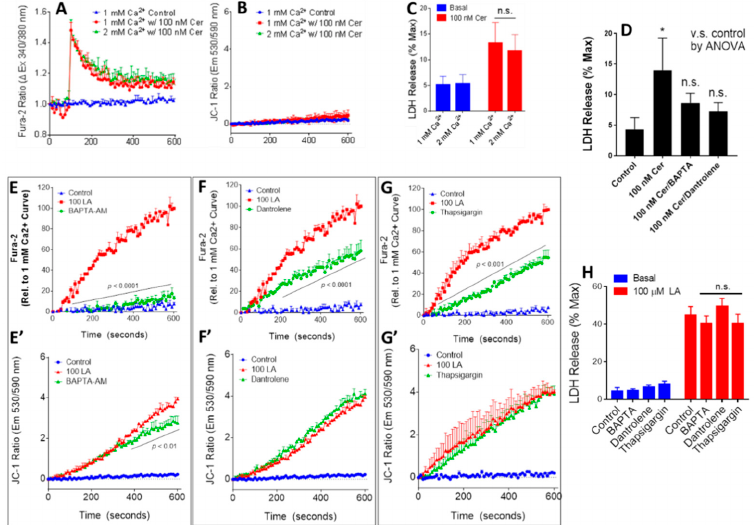
Figure 3. Effect of altering calcium on caerulein-induced ( A – D ), and changing Cai on LA-induced ( E – H ) acinar cell injury. ( A ) Extracellular calcium (1, 2 mM) had no effect on intracellular calcium